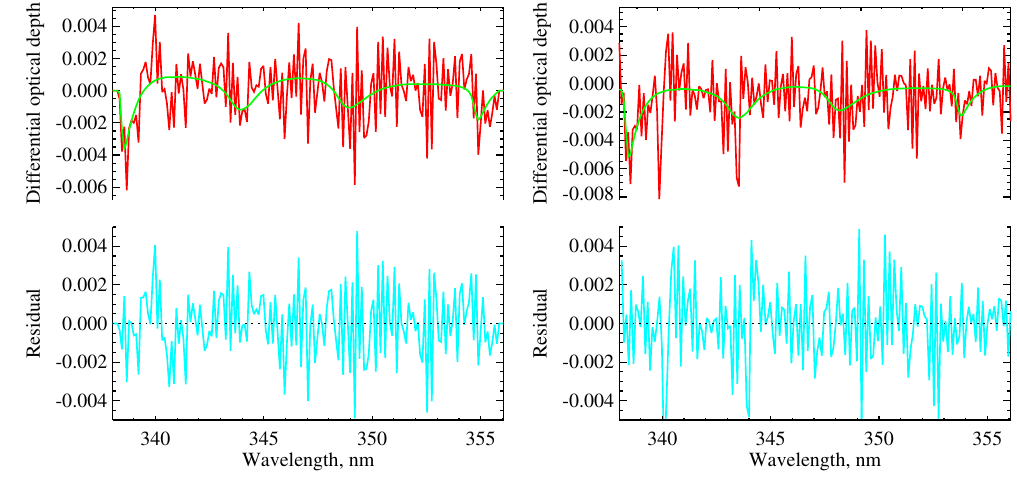
Fig. 4. Example spectral fits at a tangent height of 21km for IUP Bremen (left panels) and MPI Mainz (right panels) algorithms. Upper panels show measured (red) and simulated (green) optical depths of BrO while lower panels show fit